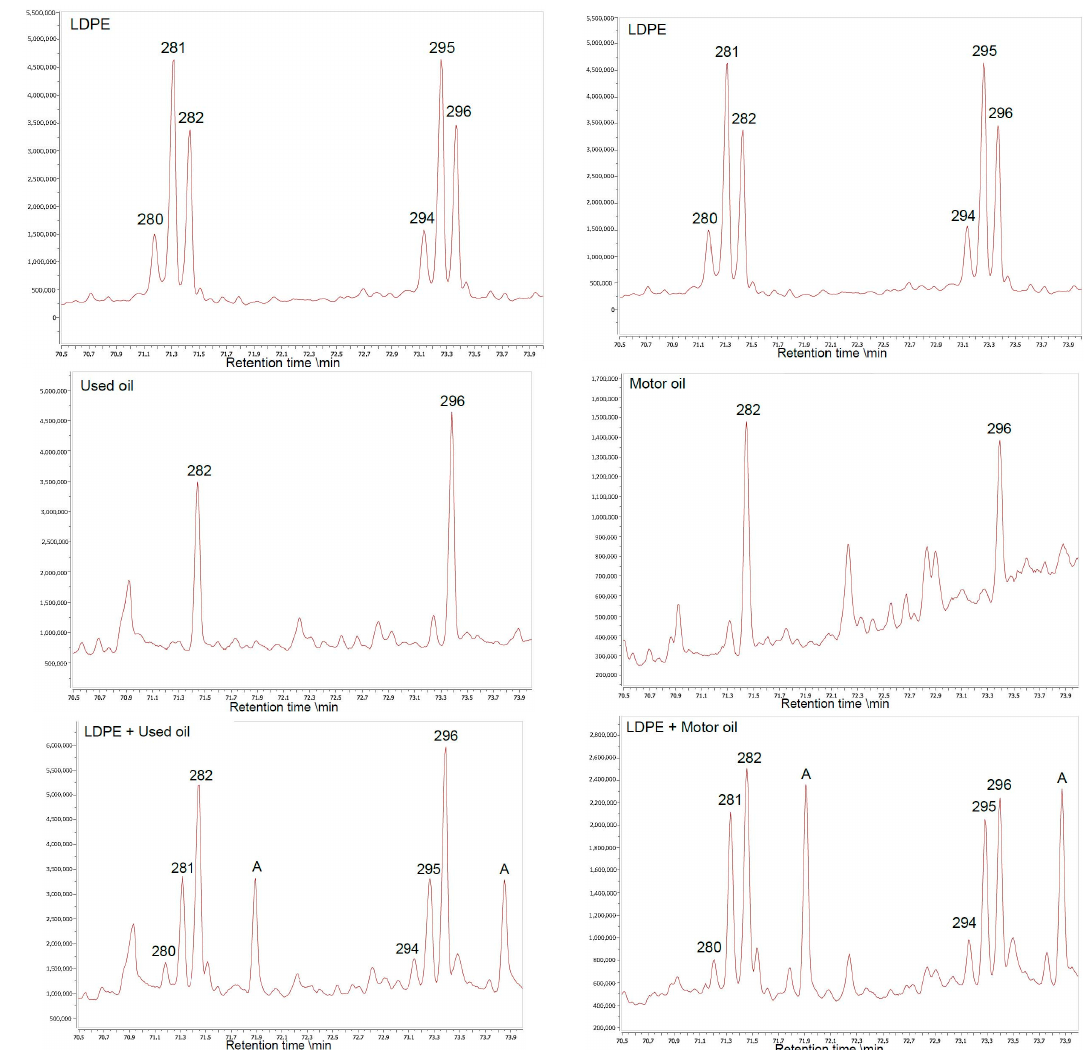
Figure 7. Focus on the Py-GC/MS chromatograms of Figures 5 and 6, between retention times 70.5 and 74 min. The m/z ratio is indicated at the top of each peak when known. A indicates the aldehydes.